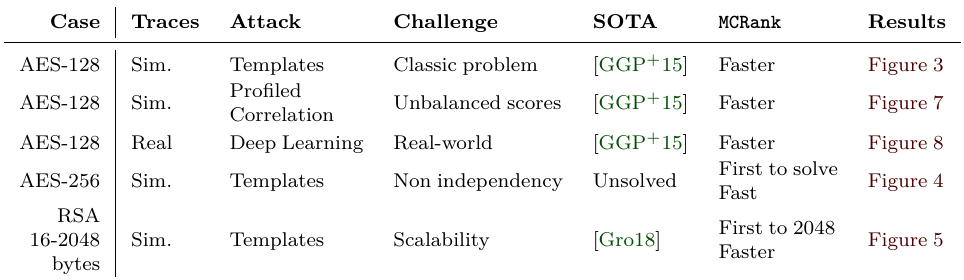
Figure 7: AES-128 with profiled correlation attack. Comparison between Histogram Enumeration and MCRank . MCRank is faster (b) while achieving comparable uncertainty (a), as long as rescaling is used (blue). Rescaling is necessary (blue vs. gray). Table 1: Comparison with State-Of-The-Art